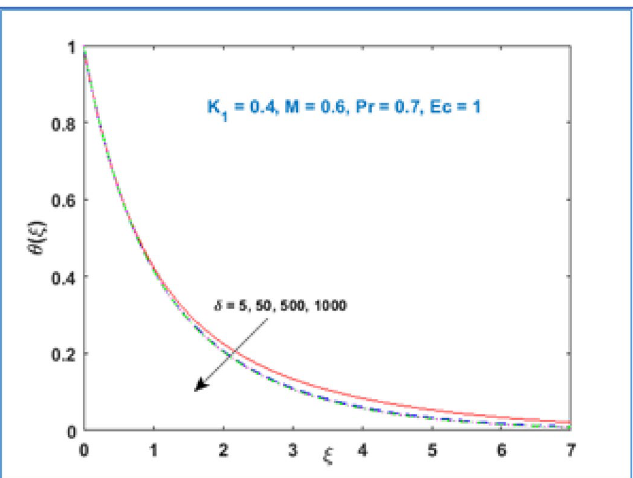
Figure 10. θ(ξ) versus δ .